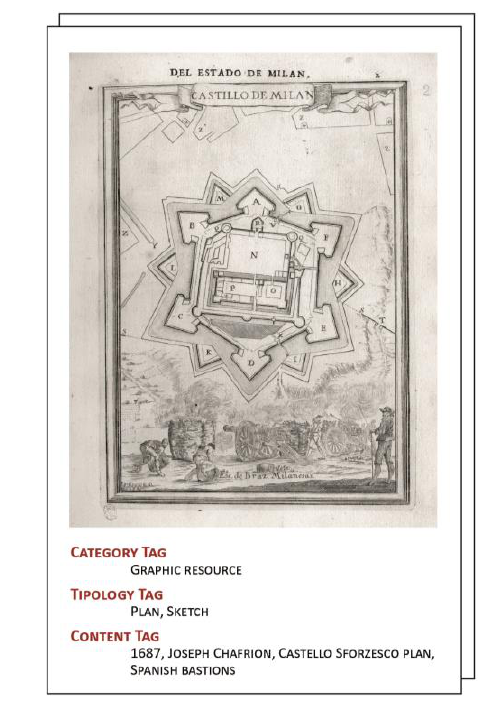
Figure 4. An example of documentation tagging For documents insertion in the database, it is sufficient to attribute the various tags to the document itself, selecting those already used. This foresight allows avoiding that some tags